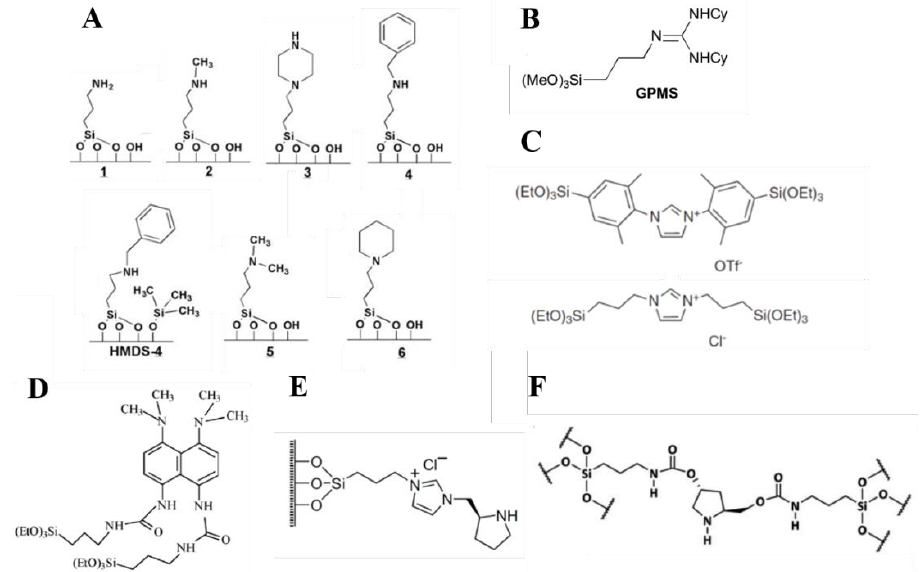
Figure 16. ( A ): Schematic representation of the grafted amines [87]. Reprinted with permission from [87]. Copyright 2010, Elsevier. ( B ): Synthesis of guanidine-based silyl-derivative [93]. Reprinted with permission from [93]. Copyright 2011, Royal Society of Chemistry. ( C ): Imidazolium-based silyl-derivatives [95]. Reprinted with permission from [95]. Copyright 2013, John Wiley and Sons. ( D ): 1,8-bis(dimethylamino)naphthalene (DMAN)-based silyl-derivative. Reprinted with permission from [96]. Copyright 2011, Royal Society of Chemistry. ( E ): Silica-supported pyrrolidine-based chiral ionic liquid [97]. Reprinted with permission from [97]. Copyright 2008, Elsevier. ( F ): Silica- functionalized pyrrolidine-based chiral hybrid catalyst. Reprinted with permission from [98]. Copy- right 2018, Royal Society of